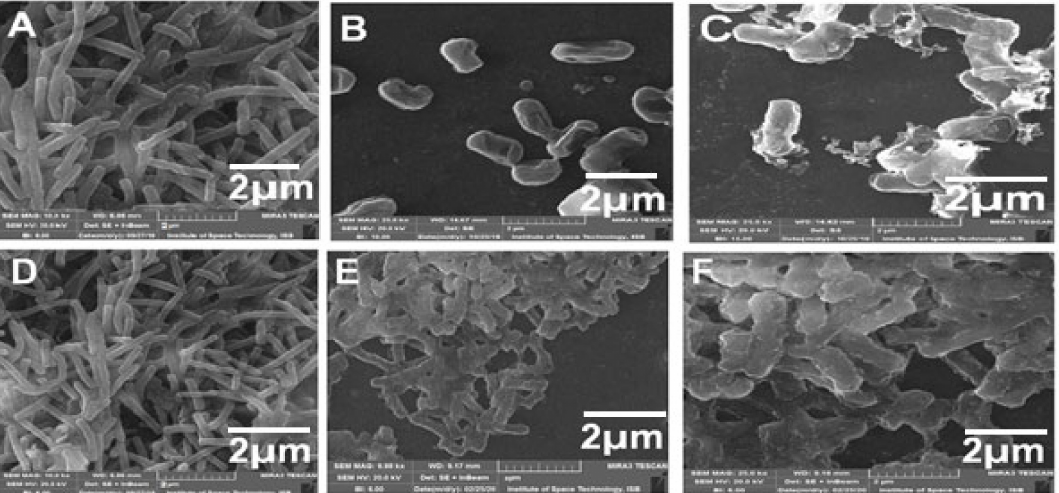
Figure 6. FESEM micrographs displaying morphological changes in MDR E. coli cells treated with CIP-Ag/TiO 2 /CS nanohybridat MIC (0.0512 µ g/mL) and at different intervals of time. ( A ) Untreated MDR E. coli cells, ( B ) MDR E. coli cells after 6 h of incubation, ( C ) MDR E. coli cells after 12 h of incubation, ( D ) E. coli with CIP at 0 h of incubation, ( E ) CIP at 6 h, and ( F ) CIP at 12 h culture of E.